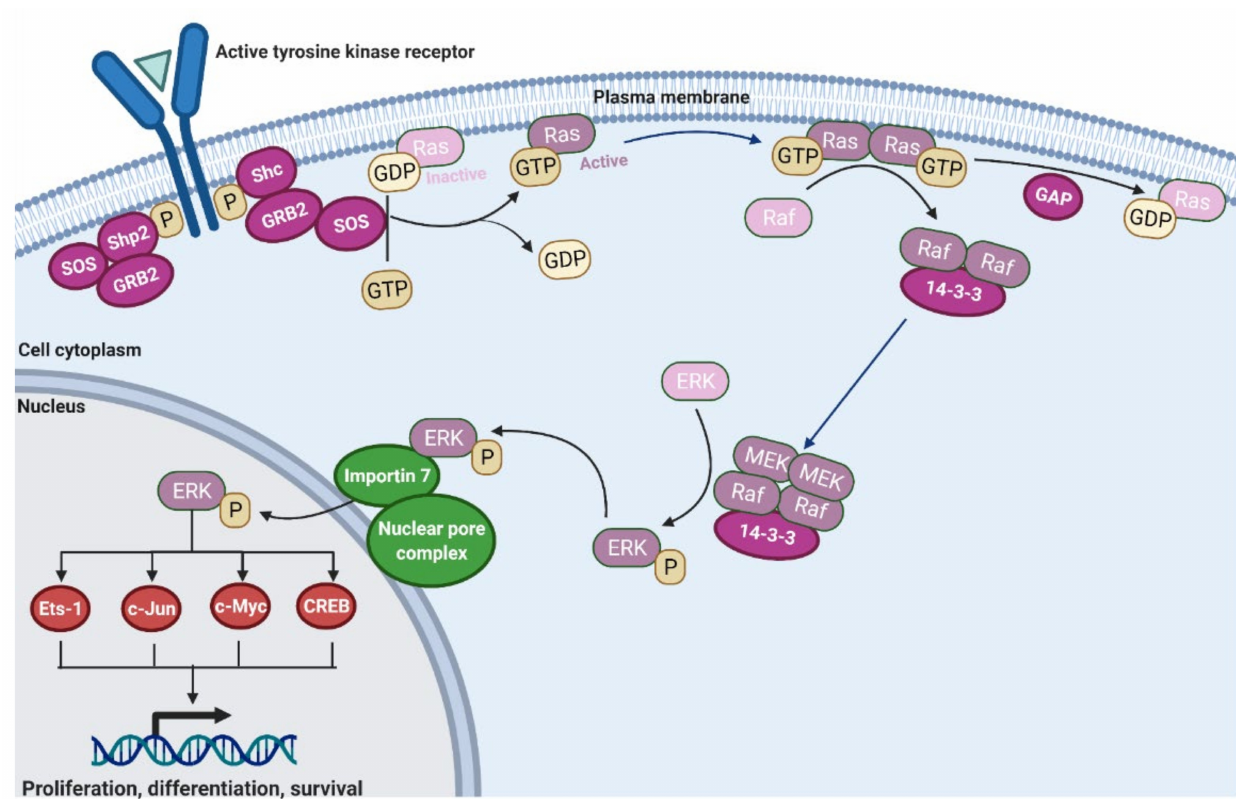
Figure 1. The MAPK cascade. Once a ligand binds the tyrosine kinase receptor, it self-phosphorylates [18]. This creates binding sites for Shc and Shp2. GRB2 can associate with either and then recruit SOS [19,20]. SOS is a guanine